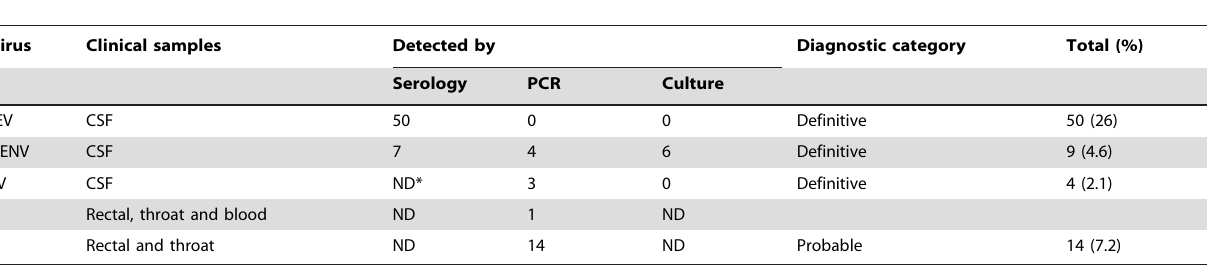
Table 4. Laboratory results of three most common viruses (JEV, DENV and EV) detected in this study.